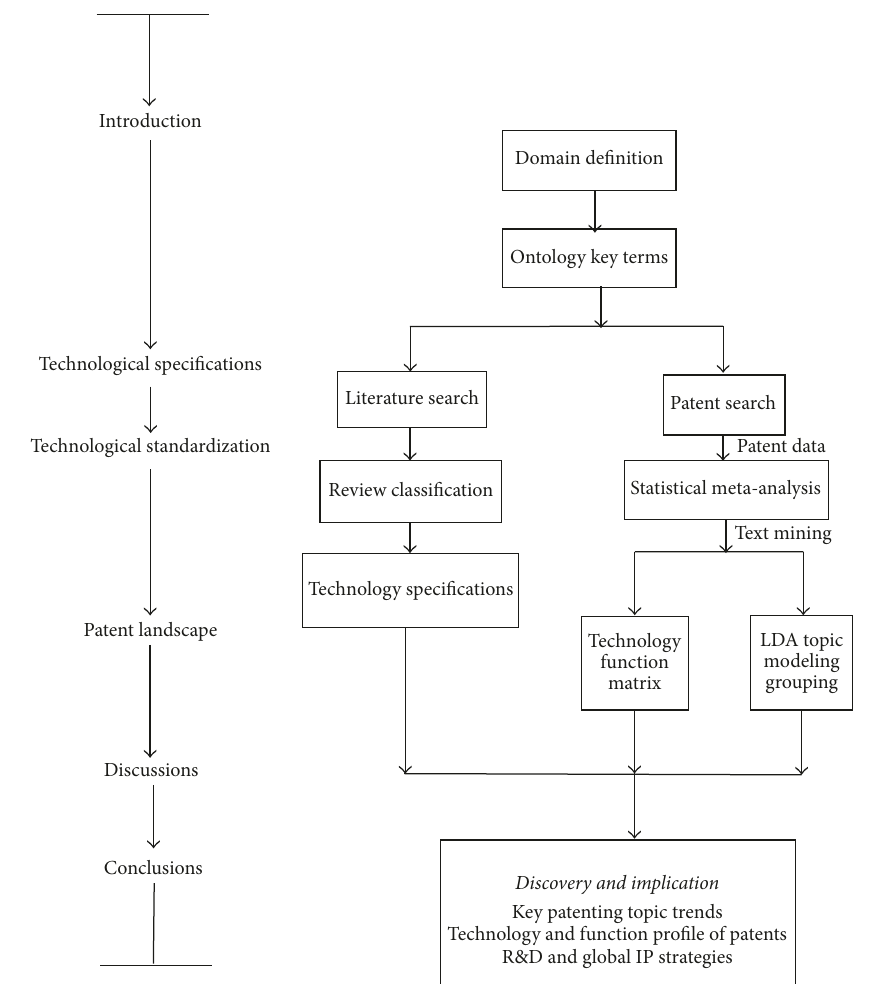
Figure 2: The research flow of a comprehensive IIT